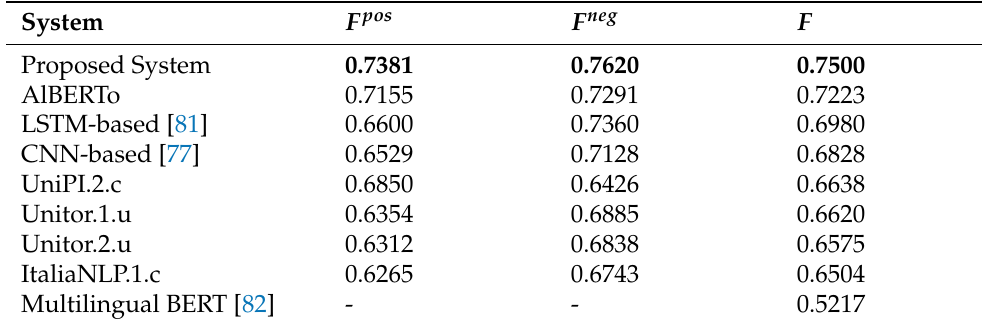
Table 6. State-of-the-art comparison.